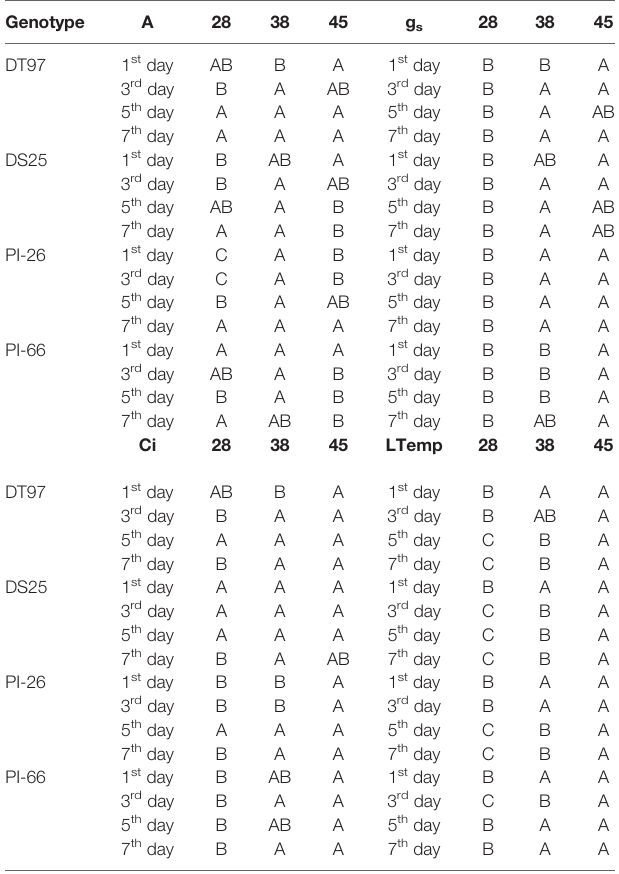
TABLE 1 | Statistical groupings from Figure 1 for photosynthetic rate (A), stomatal conductance (g s ), internal CO 2 (Ci) and leaf temperature.